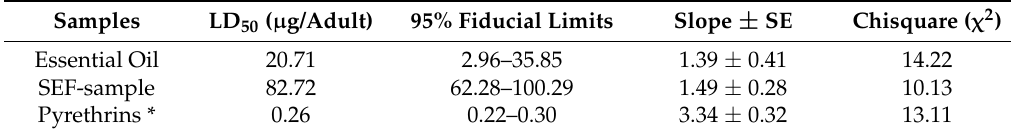
Table 2. Contact toxicity of two samples from A. officinarum rhizomes.